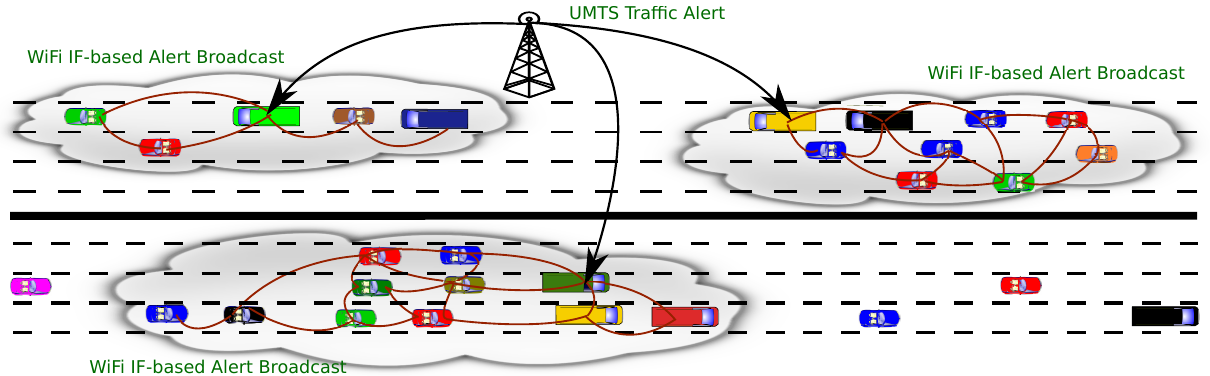
Figure 1. Illustrative Cross-Network Effective Traffic Alert Dissemination (X-NETAD) traffic alerts dissemination